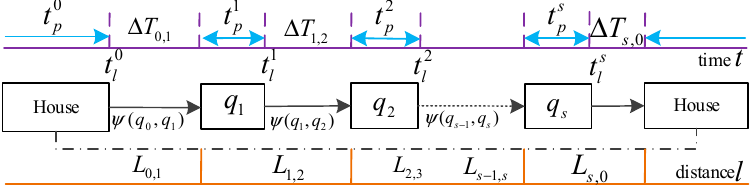
Figure 2. The daily trip